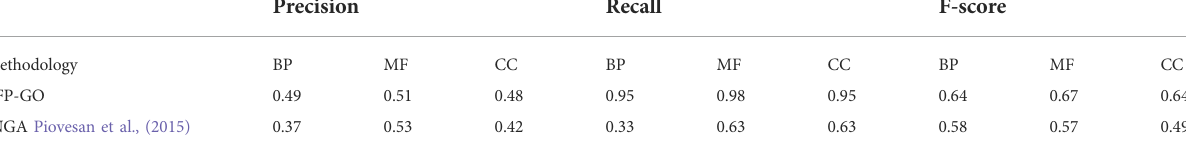
TABLE 5 Performance analysis of INGA and PFP-GO separately on CC, MF and BP.